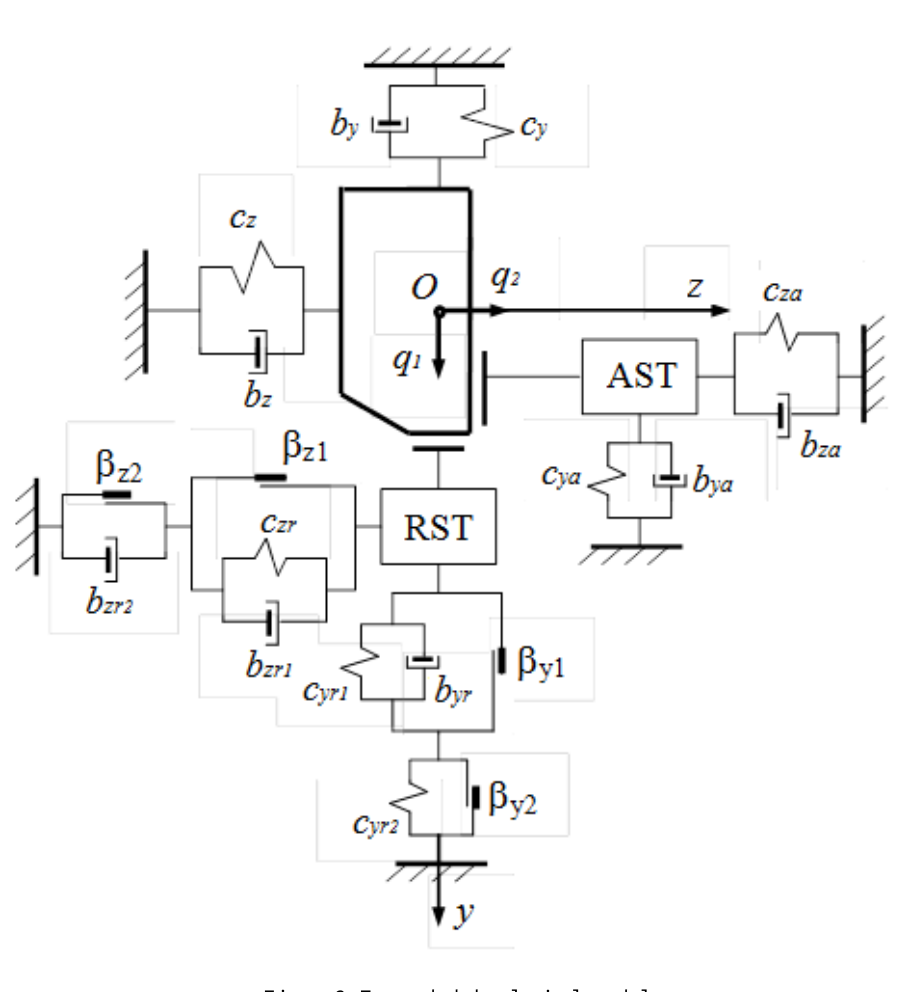
Figure 3. Expanded rheological